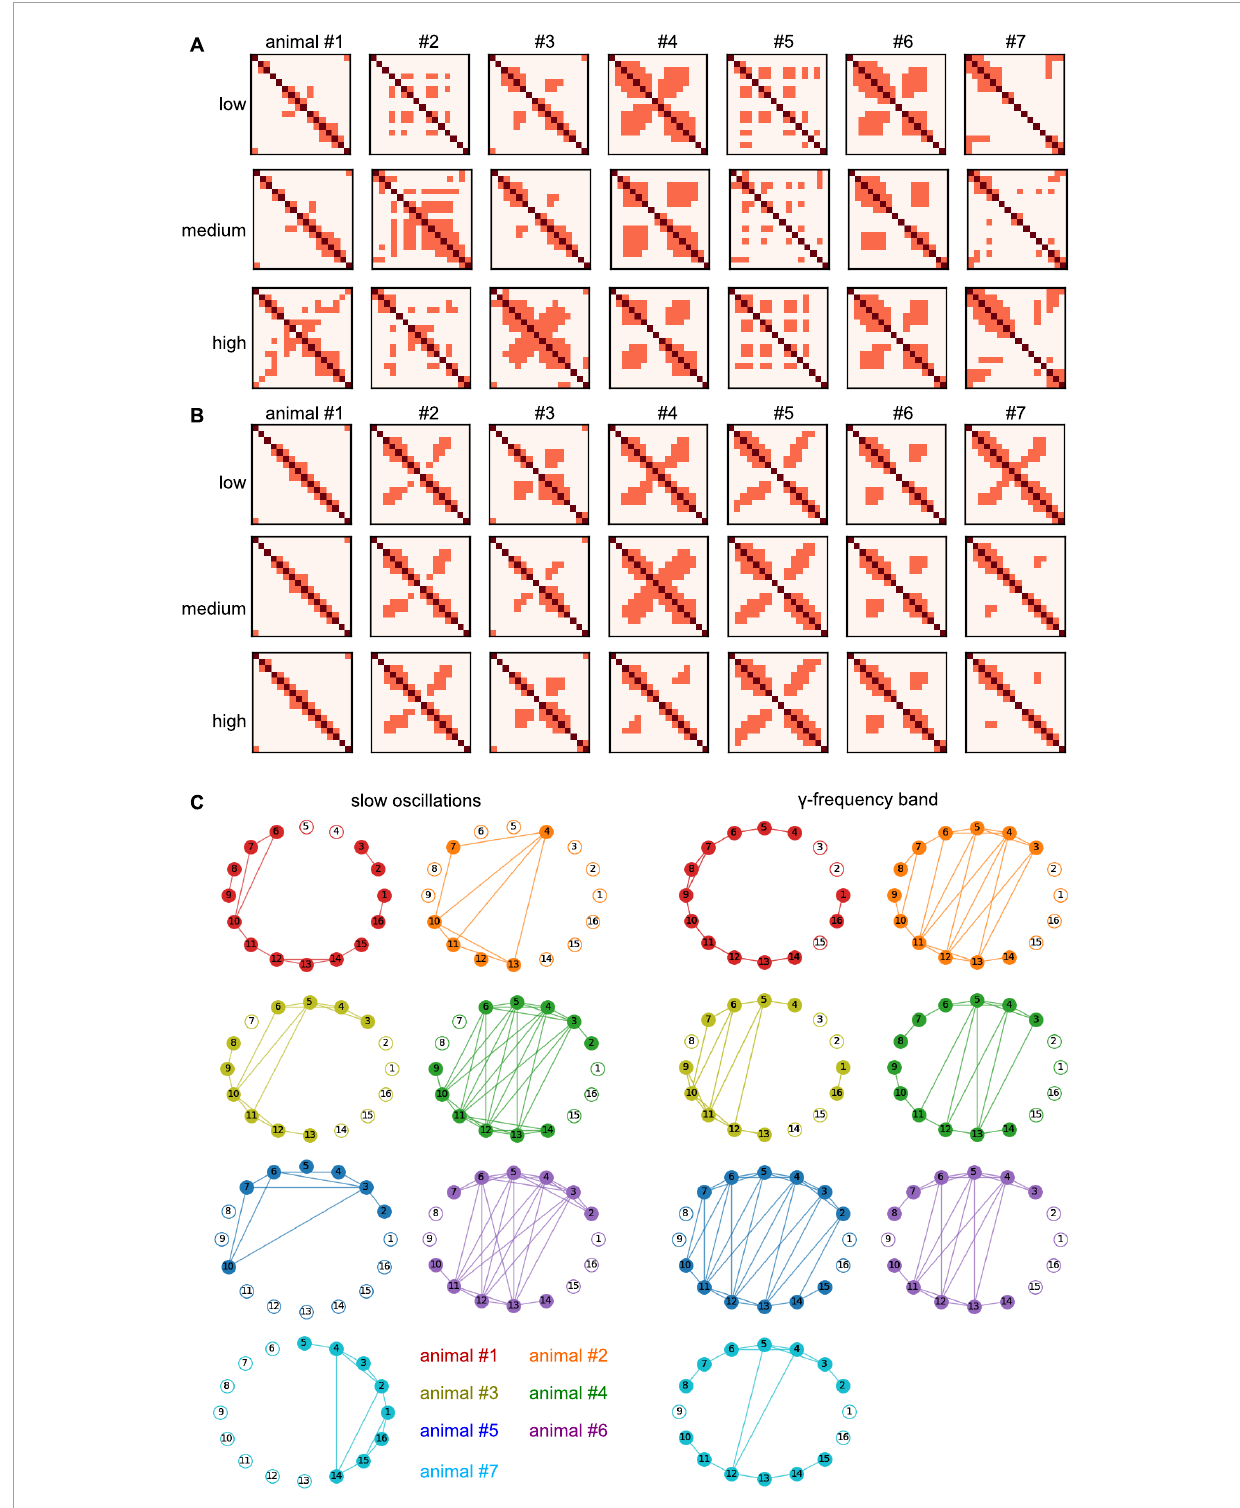
FIGURE11 Invariant connectivity at all anesthetic levels and animal subjects. (A) Mutual connection maps subject to anesthetic level and animal subject in slow oscillations. Diagonal pixels (dark red) denote self-interactions, non-diagonal pixels (light red) denote maximum synchronization connections (cf. cluster 3 in Figure 9 ) which occur in all stimulation conditions. Rows provide results at different anesthetic levels, results from different animal subjects are given in columns. (B) Mutual connection maps in γ -band activity. (C) Invariant networks which share maximum synchronization in stimulation conditions and anesthetic level, i.e., mutual connections in panels (A,B) in all anesthetic levels. Different colors encode different animal subjects. Electrodes 1–8 and 9–16 reside in separate cortical regions. # Denotes the animal